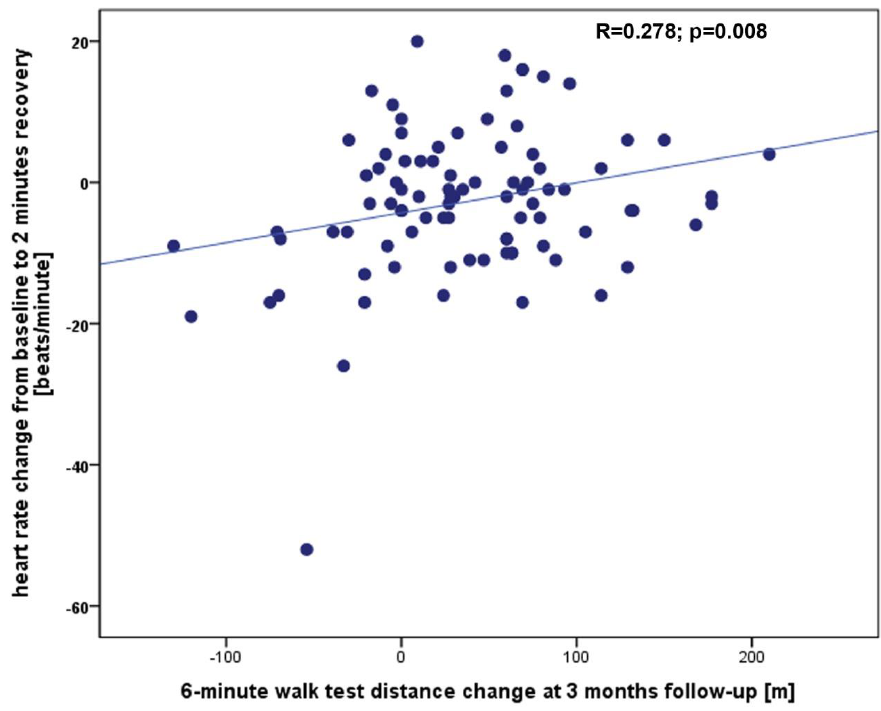
Figure 3. The correlation between the ∆ 6MWTD at the 3-month follow-up and the difference in heart rate between baseline and after 2 min of recovery.